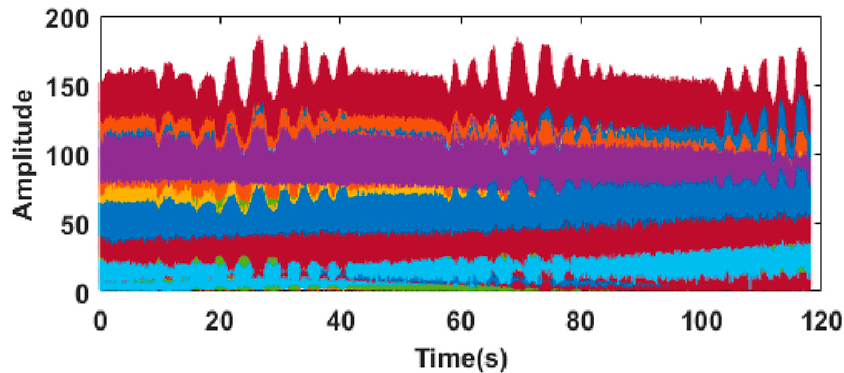
Figure 8. Cheyne-Stokes breathing waveform.